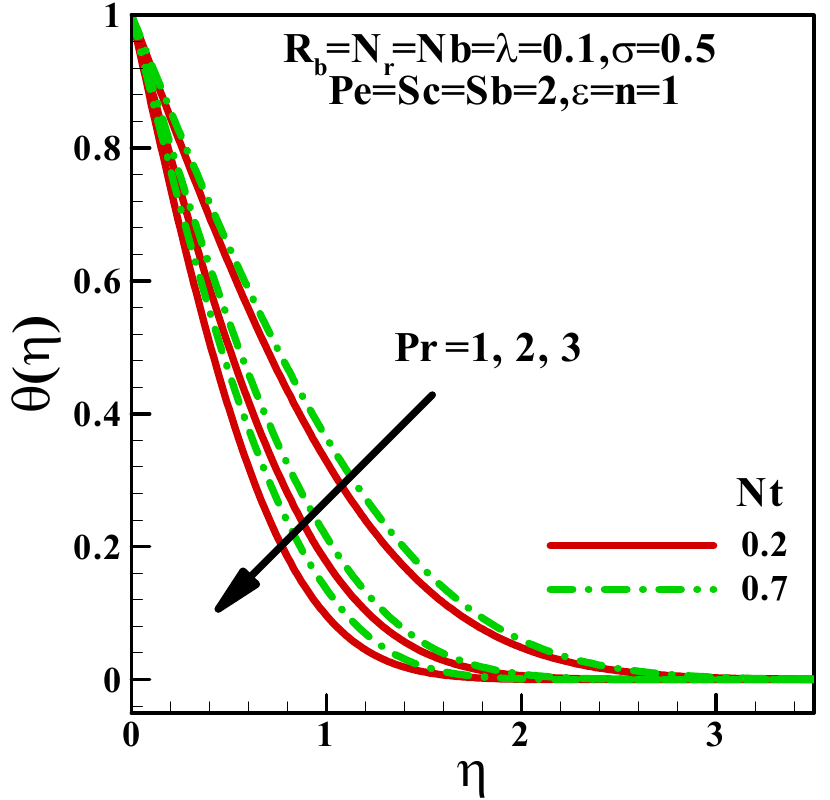
Figure 4. Variation in dimensionless temperature with the thermophoresis parameter for different fluids.